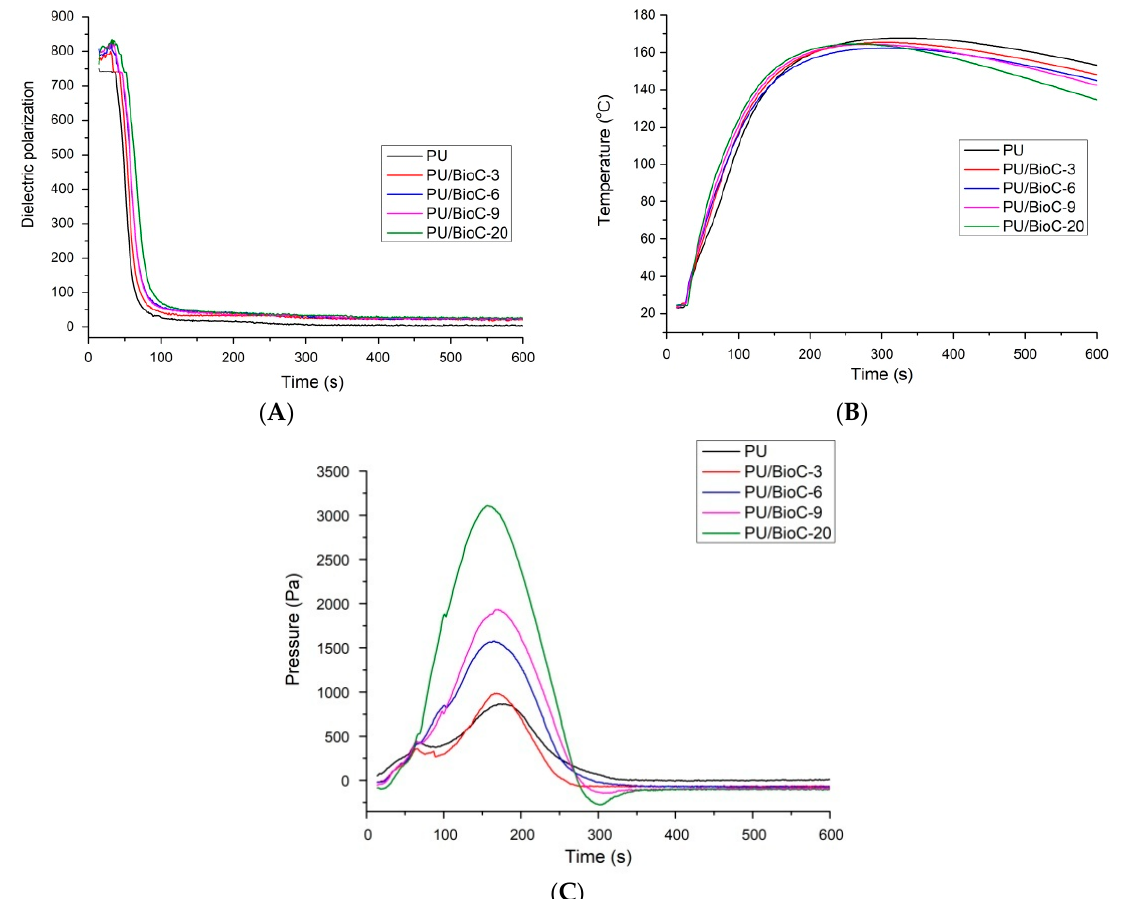
Figure 4. Influence of BioC on dielectric polarization ( A ), temperature ( B ), and pressure ( C ) changes of reaction mixture during foaming of polyurethane systems.